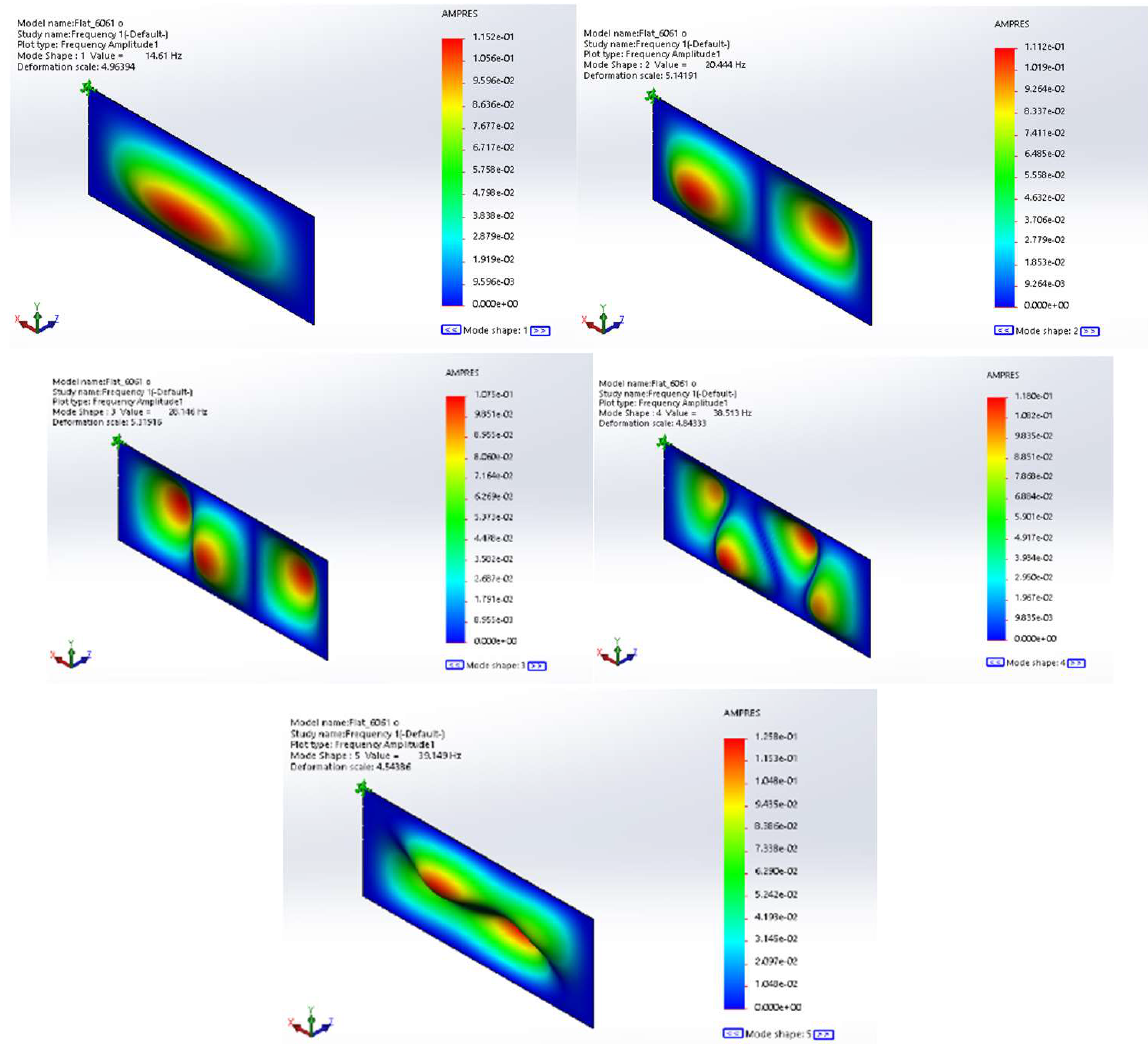
Figure 30: Mode shapes 1–5 of the flat